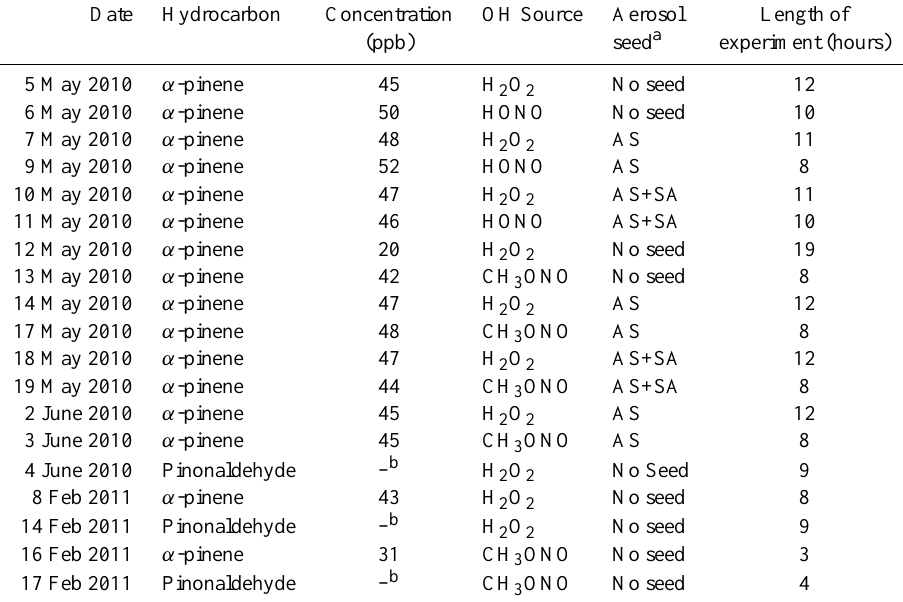
Table 1. Experimental conditions. Date Hydrocarbon Concentration OH